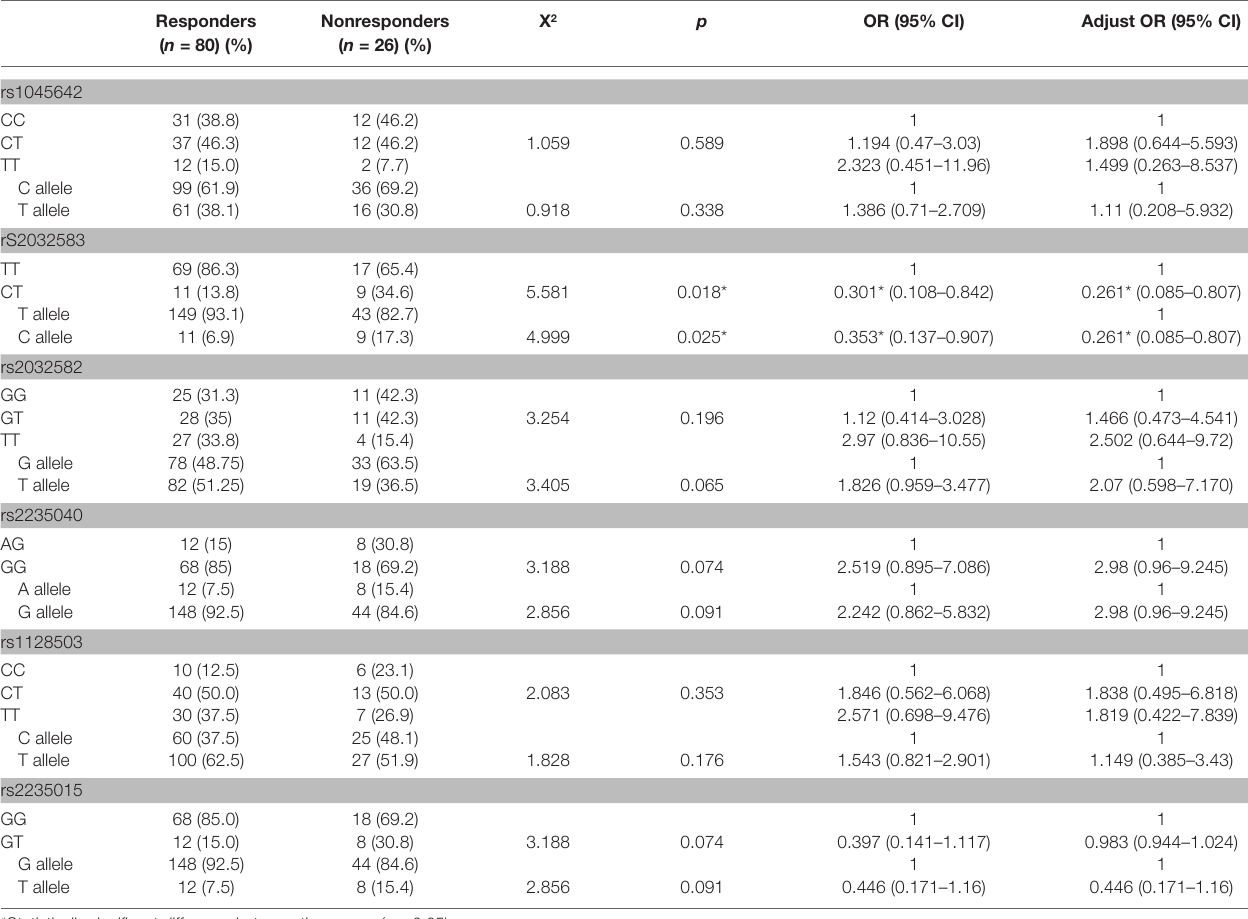
TABLE 6 | Genotype, allelic distribution of all genotyped SNPs among the treatment responders and nonresponders for serotonin-norepinephrine reuptake inhibitors (SNRIs).